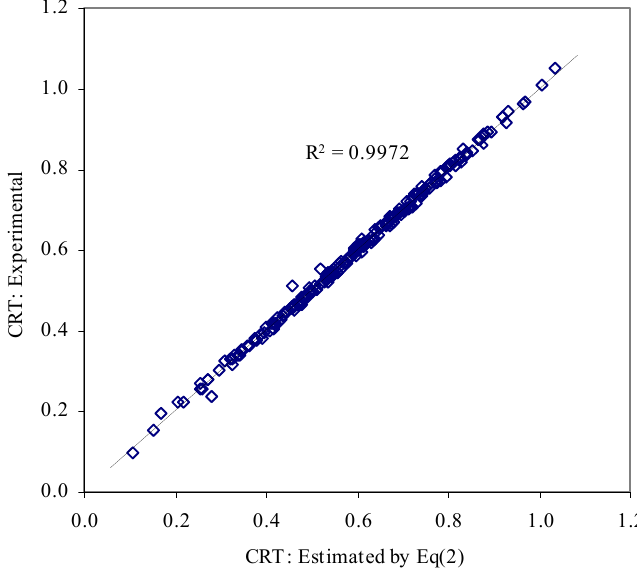
Figure 4. The plot of experimental vs chromatographic retention time (CRT) by Eq(2).